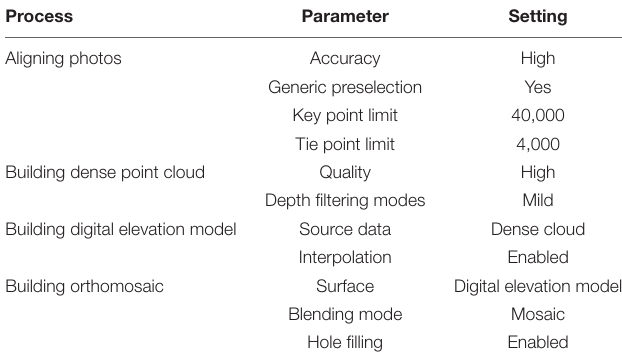
TABLE 2 | Parameters of the SfM